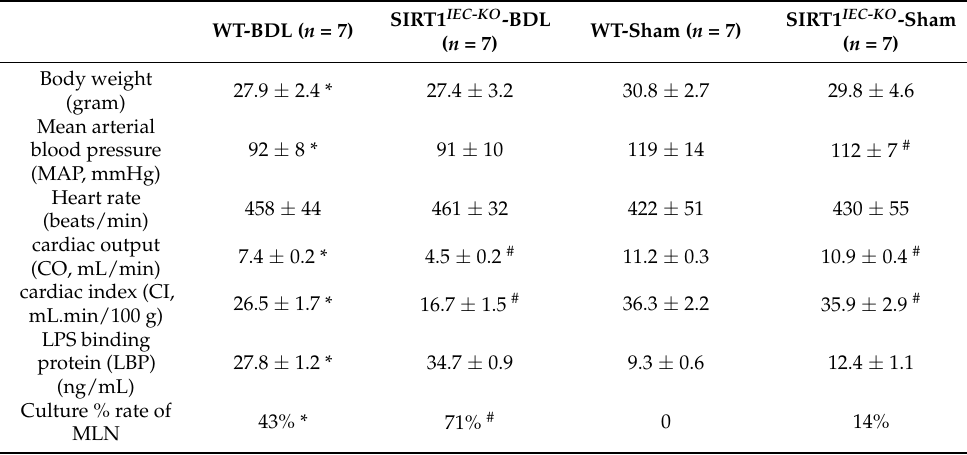
Table 1. Hemodynamic parameters of mice in different groups.